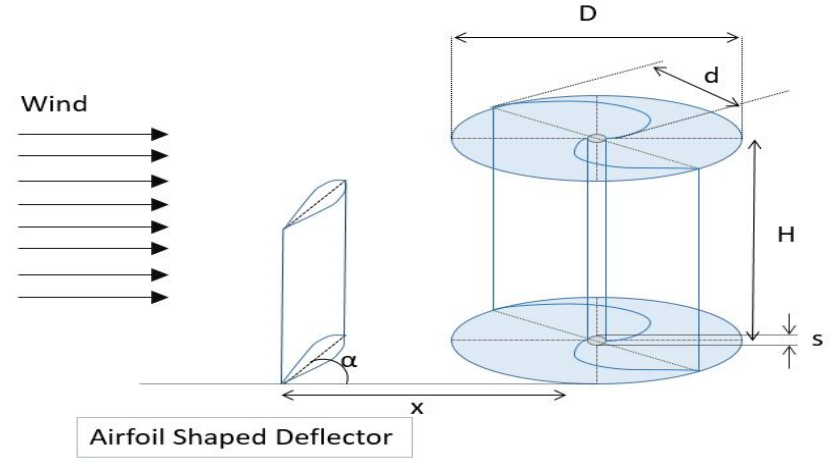
Figure 6. An airfoil-shaped wind deflector in the upstream of a Savonius rotor [75]. An airfoil deflector distributes the cube of wind stream evenly towards the forward blade of the Savonius turbine. There is less separation observed at the tailing edge compared to a flat-plate deflector with the same angle of attack (AOA). However, the AOA significantly affects the position of the separation point on the airfoil, which ultimately affects the performance [76]. The maximum coefficient of performance for the design given in Figure 6 can be increased up to 50% with a tip speed ratio (TSR) of 1.3. 6 concluded that a Savonius turbine achieves its maximum torque and power coefficients at an AOA of 70°. The performance of the turbine can be characterized by the torque coefficient and power coefficient. The power coefficient ( 𝐶 (cid:3043) ) is the ratio of rotational power produced by the rotor ( 𝑃 (cid:3045) ) to the kinetic power available in the wind streams ( 𝑃 (cid:3038) ). Similarly, the torque coefficient ( 𝐶 (cid:3047) ) is the ratio of effective torque generated by the rotor to the total available torque.